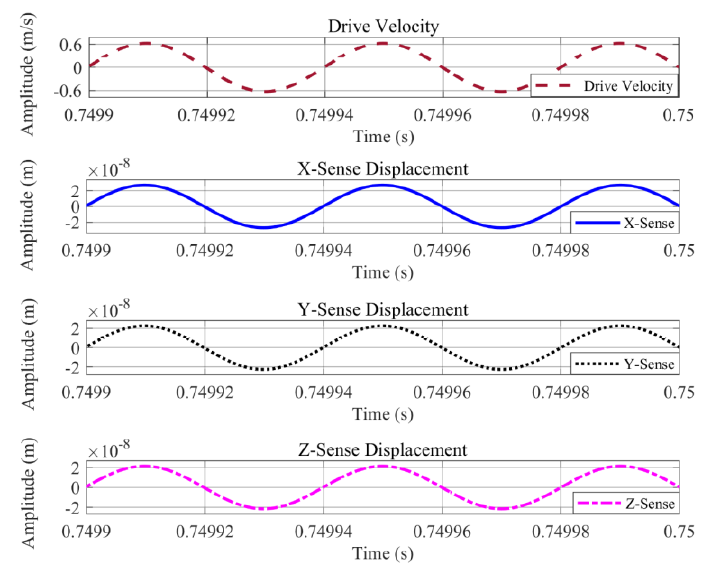
Figure 9. Drive-mode analysis of the proposed single-drive, 3-axis MEMS gyroscope using Matlab/Simulink.